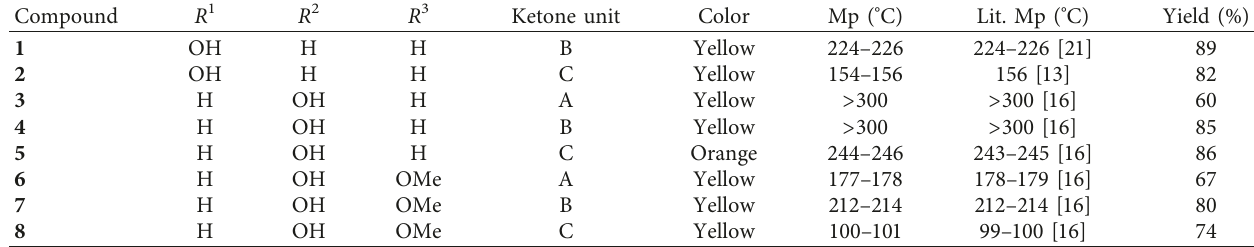
Table 1: Synthesis of curcumins 1–8 based on Scheme